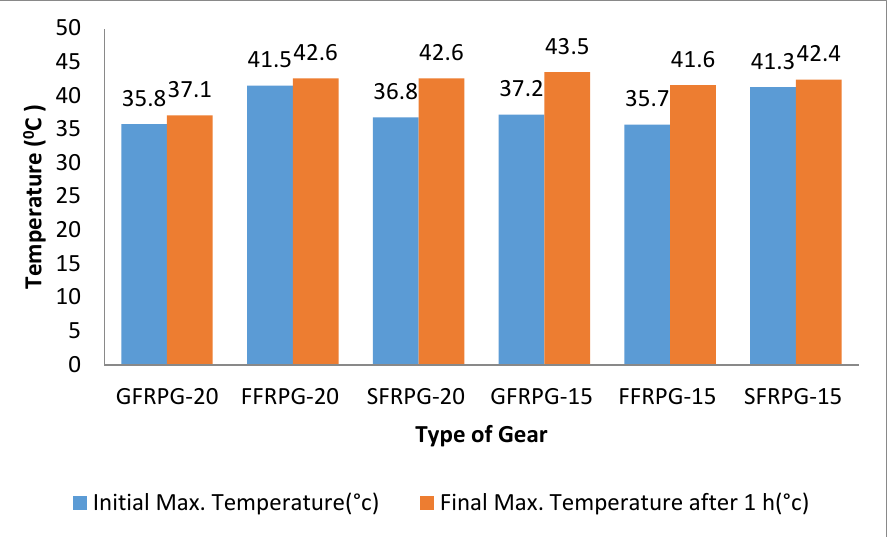
Figure 11. Comparision of initial and final temperaturesof all gears.